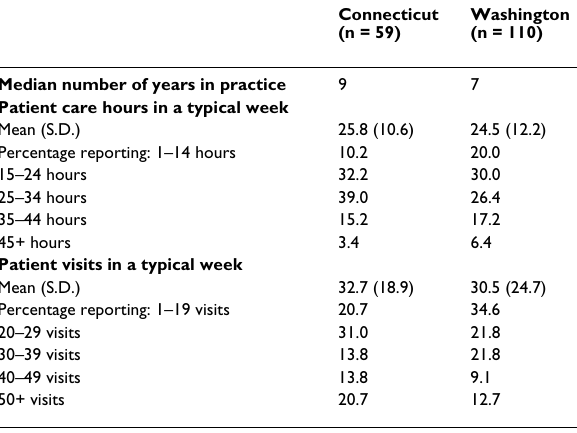
Table 4: Characteristics of visits to naturopathic physicians in Connecticut (1999) and Washington (1998) Connecticut Washington (n = 59) (n = 110) Gender